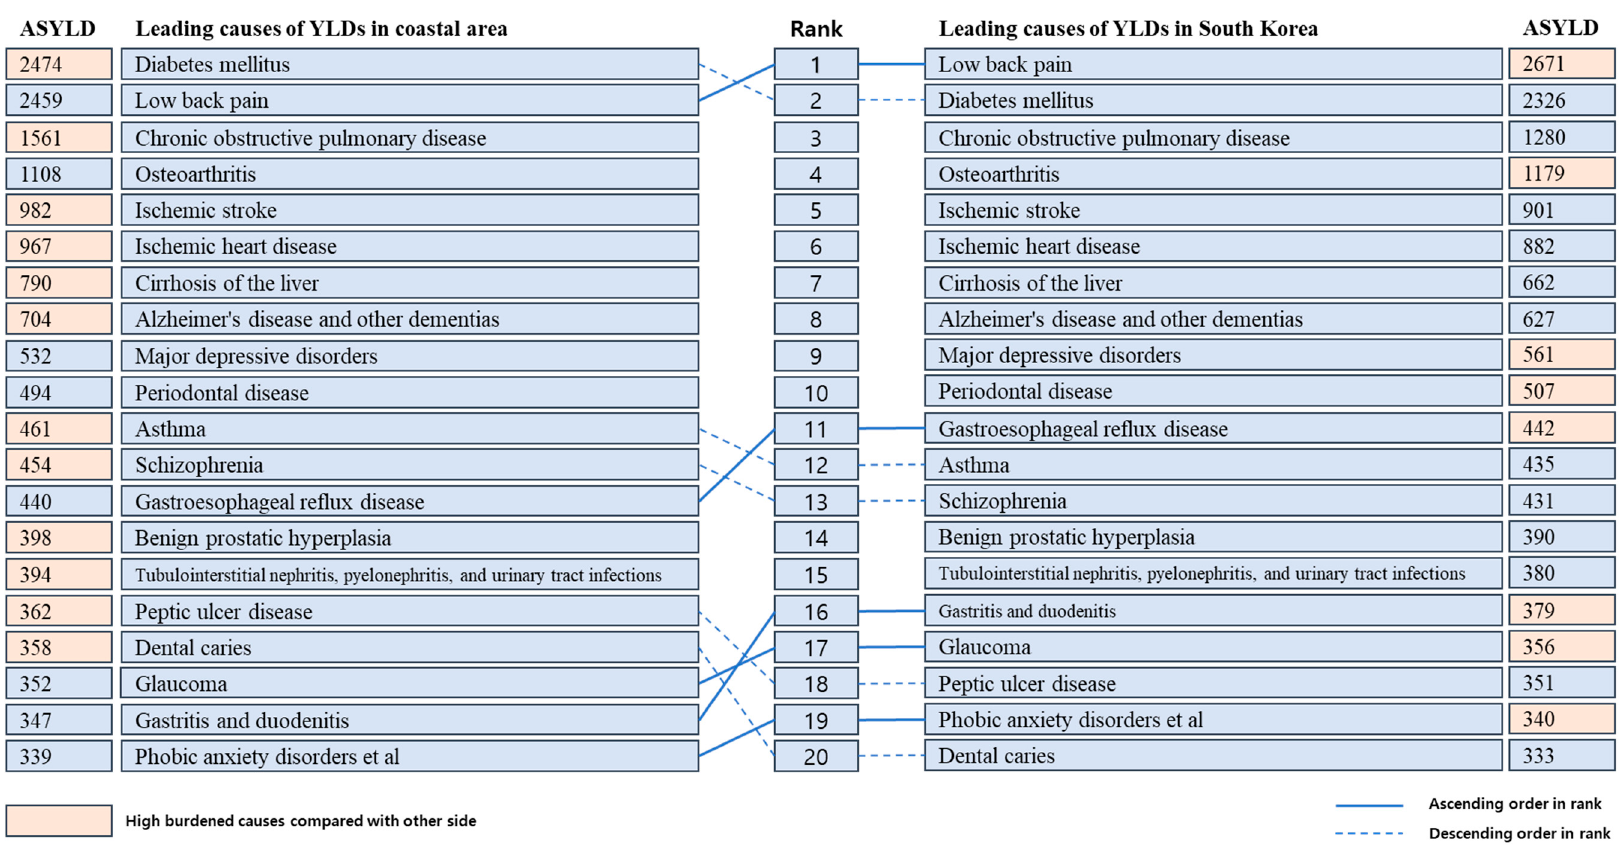
Figure 1. Top 20 leading causes (Level 3) of ASYLDs in the study population and total population, 2015. Abbreviations: ASYLD, age-standardized years lived with disability; YLDs, years lived with disability. Ascending and descending order in rank is based on ASYLD in coastal areas.